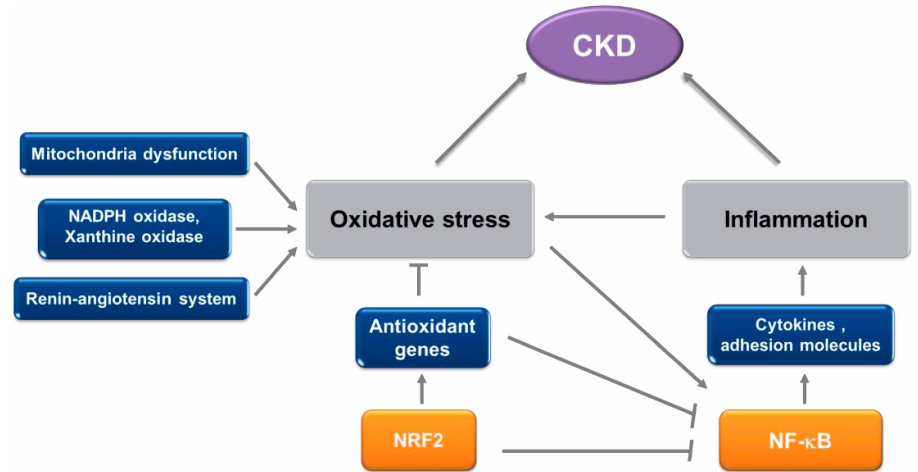
Figure 2. Factors involved in the progression of kidney dysfunction in CKD and the role of NRF2. In CKD, the alteration of mitochondrial function and the activation of ROS-generating enzymes such as NADPH oxidase and xanthine oxidase participate in aggravated oxidative stress condition in the kidney. The activation of the renin-angiotensin system is another important contributing factor. In addition, oxidative stress triggers NF- κ B activation and enhances inflammatory response, which is an important pathologic component of CKD. NRF2 provides renal cells with antioxidant potential by up-regulating an array of genes and consequently attenuates the production of pro-inflammatory cytokines and adhesion